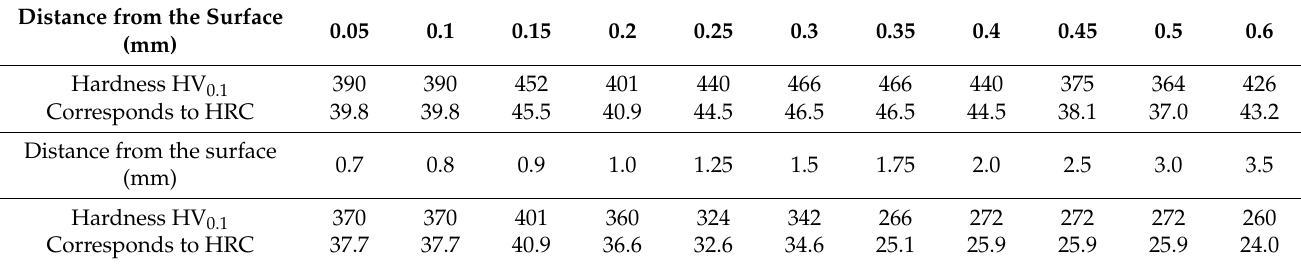
Table 8. Microhardness of the inactive tooth flank of the tooth hard-faced with the DUR 600-IG FM—direction